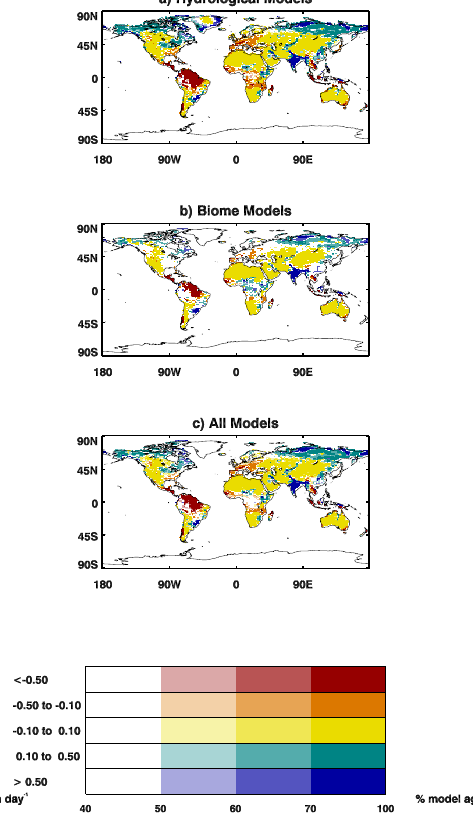
Fig. 2. Ensemble consensus for runoff change between 1981–2010 and 2070–2099 for (a) hydrological models, (b) biome models and (c) all models when forced with HadGEM2-ES RCP8.5 climate. Each colour shows the category of runoff change, while lighter (darker) shades indicate the proportion of models agreeing with that category of change. Runoff changes were calculated individ- ually for each model, and then the consensus across these individ- ual model changes were calculated for hydrological models, biome models and all models.